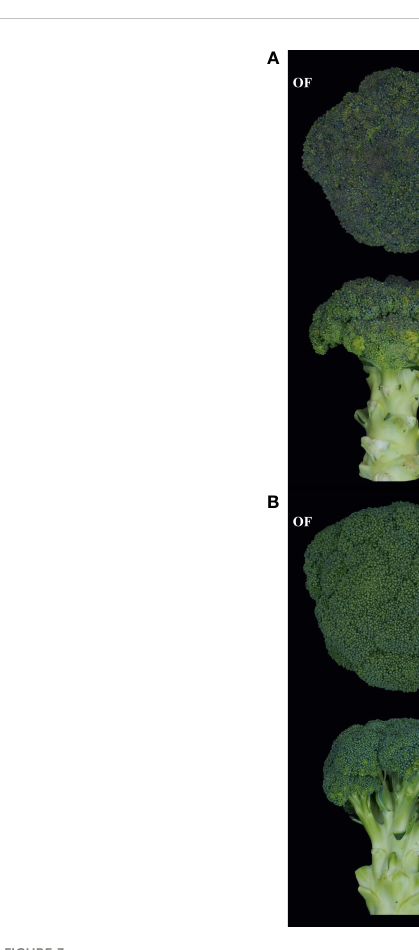
FIGURE 3 Representative photos for each treatment group (OF, open- fi eld; APV, agriphotovoltaic) of spring 2022 ‘ Earlyyou ’ (A) and ‘ Youil2ho ’ (B) . Representative broccoli corresponding each treatment was expressed as picture of its shape of top (above) and side (bottom). There were no pictures in the fall of 2021, but similar tendency was emerged to spring of 2022 borccoli by treatments.